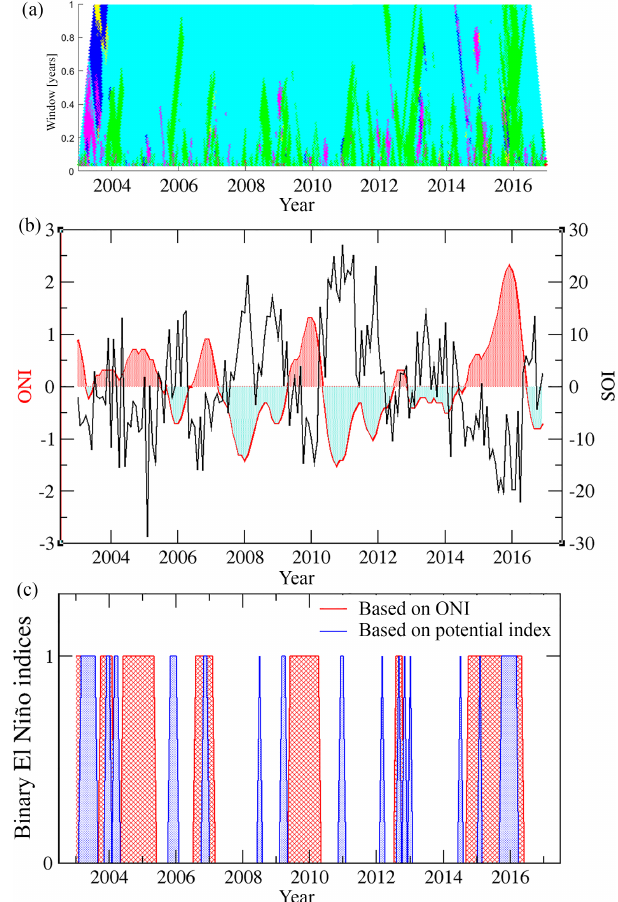
Figure 5. (a) Potential analysis plot of the broadband SPL data, with varying window length ( y axis) from 1 day to 1 year. The colours denote the number of detected potential states: green – two; cyan – three. Specks of magenta denote very short periods of a higher number of states, which correspond to highly variable (possibly non-potential) subsets of data of small size. (b) ENSO indices ONI and SOI, known to be anti-correlated, which indicate several ENSO events (El Niño and La Niña). These can also be seen in the poten- tial analysis plot. ONI positive and negative values (roughly corre- sponding to El Niño and La Niña) are shaded by light red and light blue respectively, for better comparison with the indices in the lower panel. (c) Binary indices derived from the ONI and potential plot (at the level 0.5 year of y -scale in the top panel) which have values 1 when there is an El Niño (in the case of ONI-based binary index) or anomalous potential state (in the case of the potential binary